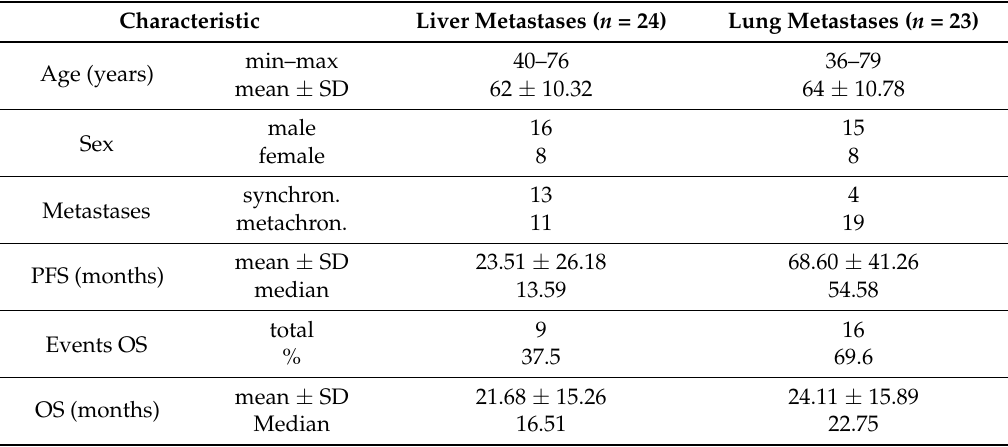
Table 1. Descriptive data of included